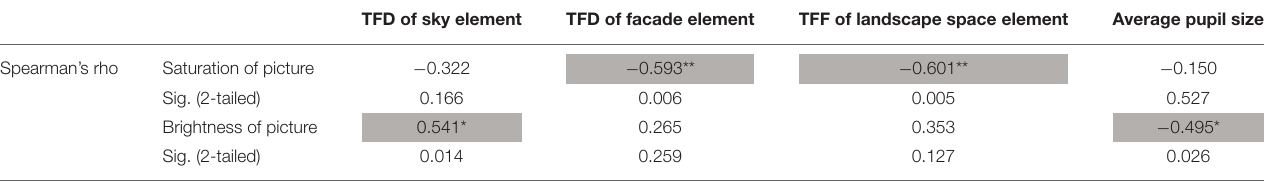
TABLE 10 | Correlations coefficient between the saturation & brightness of sample pictures and EMM. TFD of sky element TFD of facade